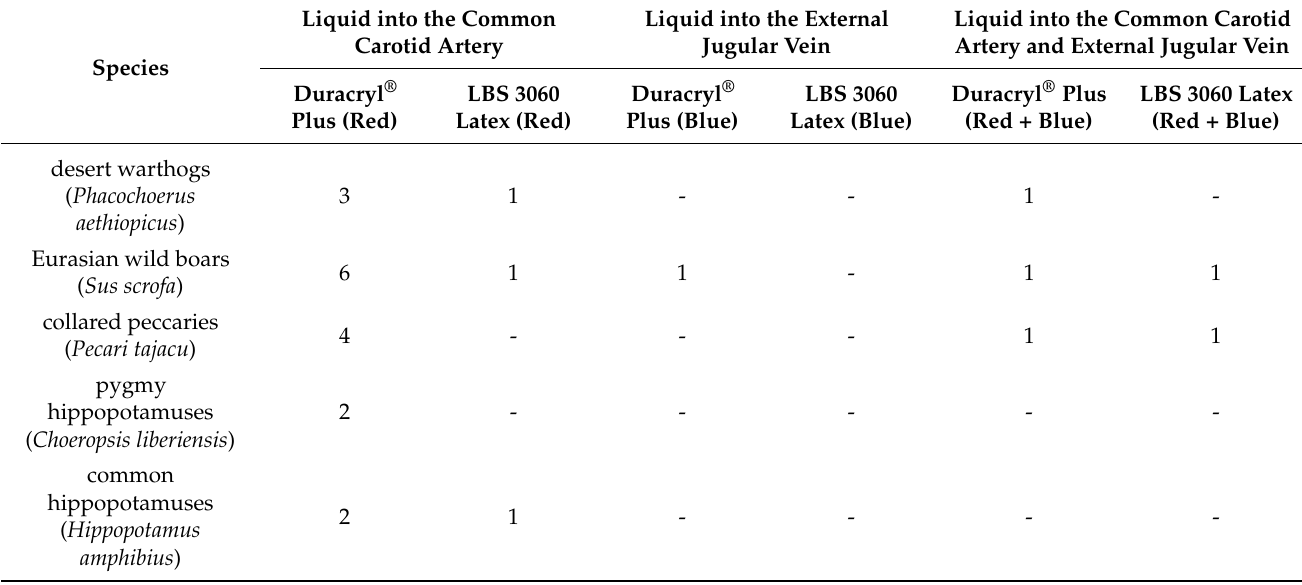
Table 1. The number of specimens examined in this